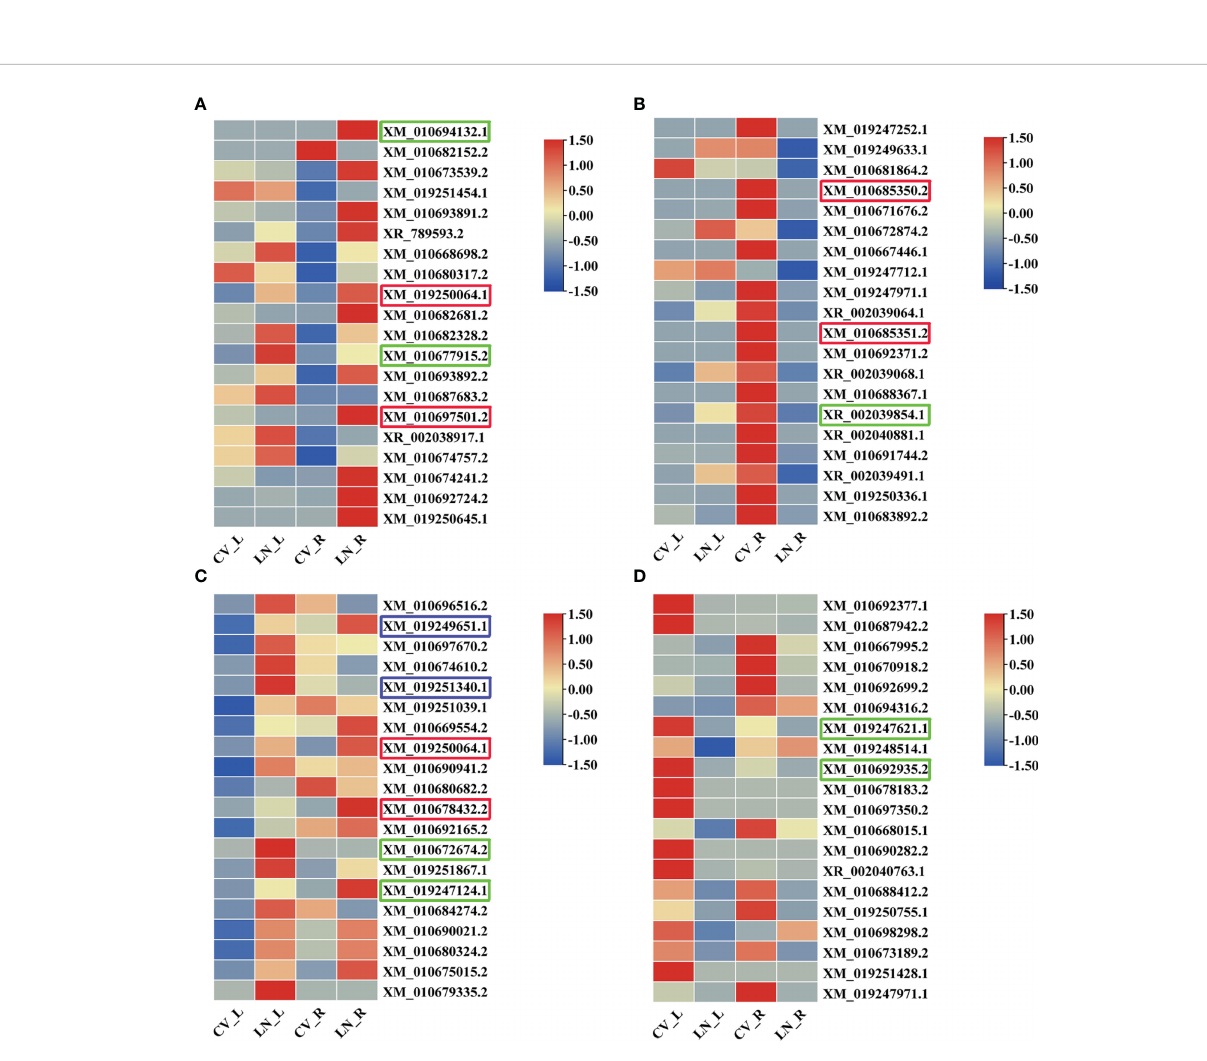
FIGURE 3 Heatmap of the top 20 signi fi cantly upregulated ( A , roots; C , leaves) and downregulated ( B , roots; D , leaves) DEGs responsive to LN in sugar beet. The redder the color, the more pronounced the expression of that transcript. DEGs, differentially expressed